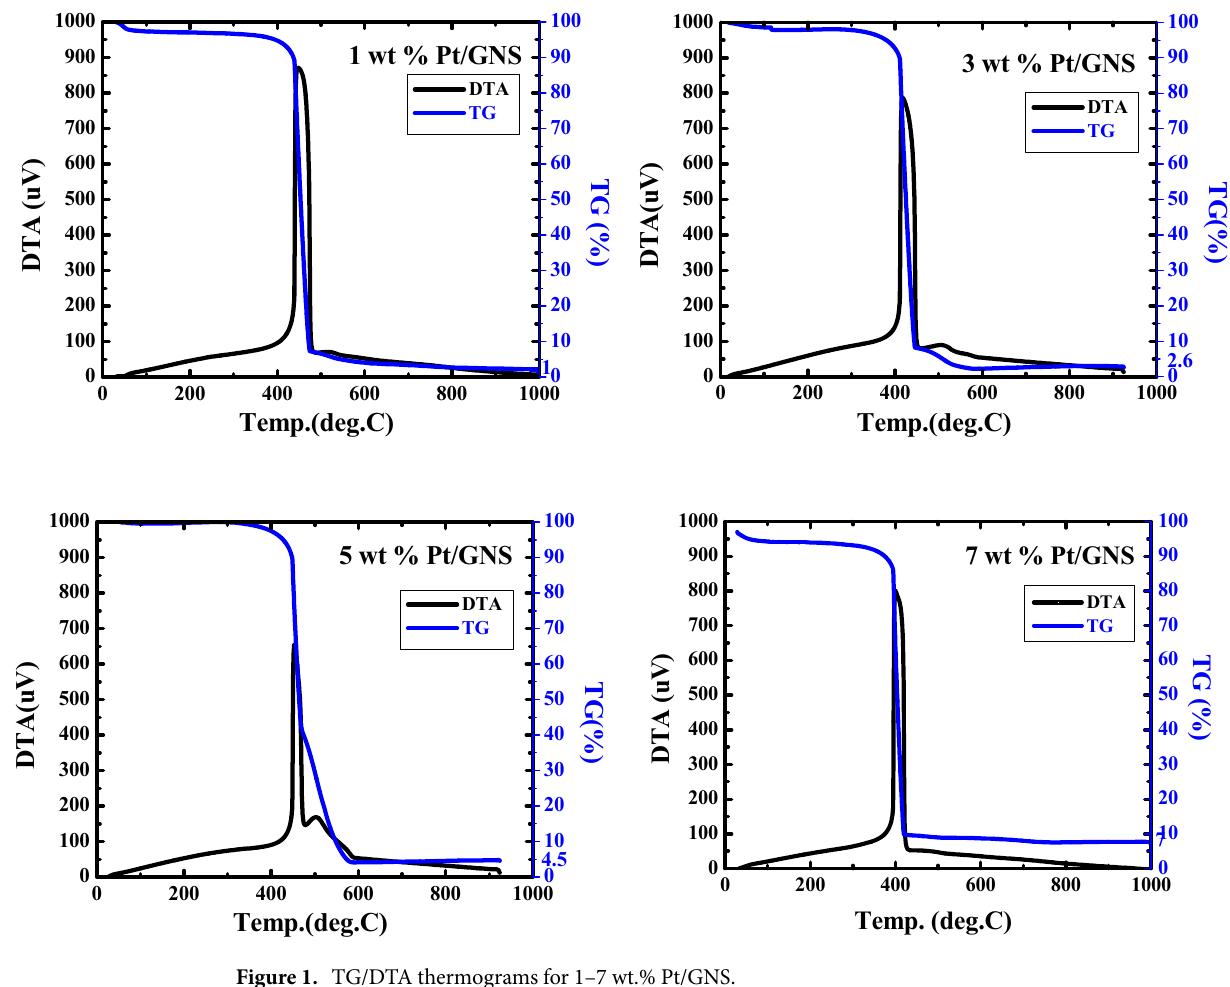
Figure 1. TG/DTA thermograms for 1–7 wt.%